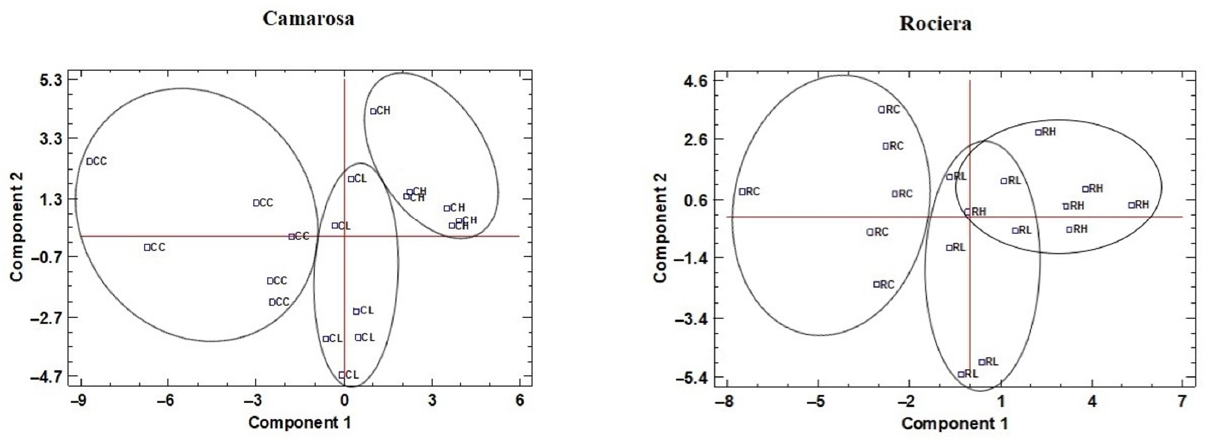
Figure 4. Principal component analysis scatterplot of the measured variables, based on the treatments imposed. CC, Camarosa control; CL, Camarosa 2 dS m − 1 ; CH, Camarosa 4 dS m − 1 ; RC, Rociera control; RL, Rociera 2 dS m − 1 ; RH, Rociera 4 dS m − 1